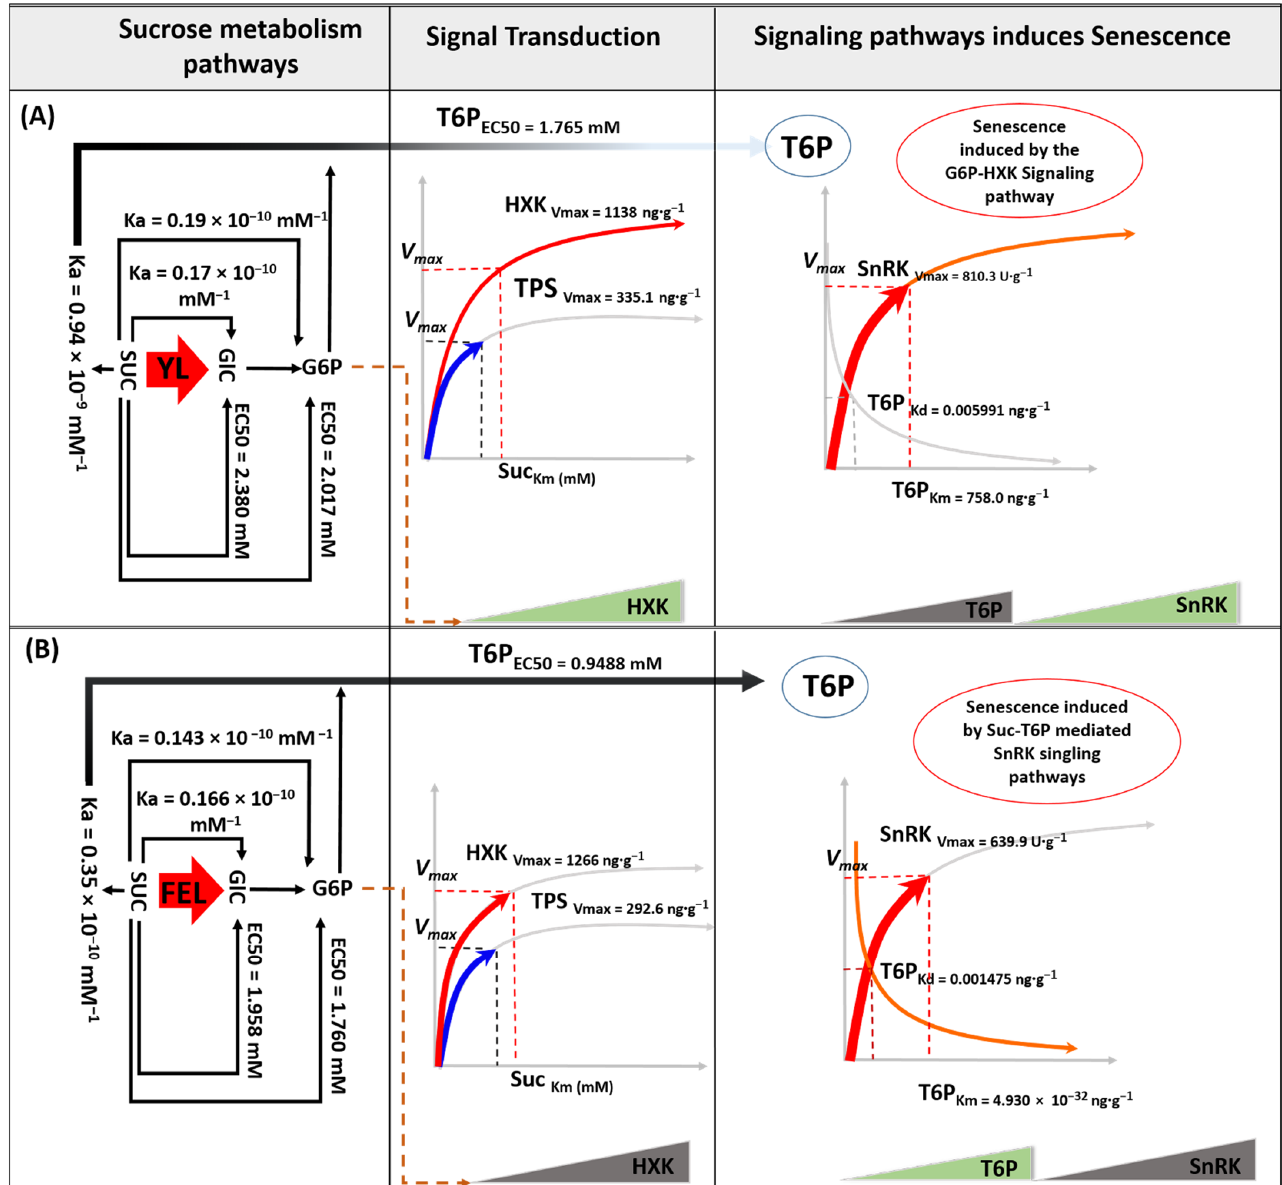
Figure 5. Schematic illustration of sugar metabolism and senescence induction in detached N. tabacum YL ( A ) and FEL ( B ) discs in response to exogenous sucrose (Suc) application. The schematic model represents simulated metabolite dynamics induced by external Suc application. This includes Suc breakdown and absorption by the detached leaf discs, metabolism via dynamic sugar signaling (specifically G6P-HXK and T6P-SnRK), and signaling pathway regulation in detached YL and FEL discs during induced senescence.